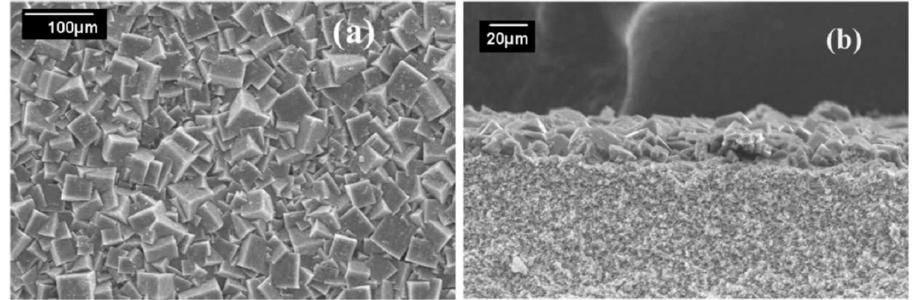
Figure 1. SEM images of the MOF-5 membrane: ( a ) top view; ( b ) cross section. Reprinted with permission from Reference [47]. Copyright 2009 Elsevier.